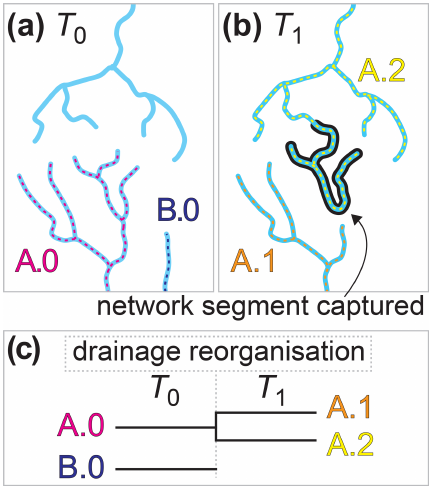
Figure 1. Conceptual model of drainage reorganisation and river- ine species macroevolution. Three stream networks exist in a hypo- thetical landscape at time T 0 (a) . Riverine species A.0 inhabits the lower-left stream network and B.0 inhabits the lower-right network. Drainages reorganised between T 0 and a later time, T 1 . Reorganisa- tion was carried out by a stream capture whereby a network segment broke off the lower-left network and joined the upper network (b) . Members of species A.0 that existed in the captured segment dis- persed throughout the upper network, creating two populations of this species in distinct stream networks that speciated child species A.1 and A.2. Drainage reorganisation also led to the stream network of B.0 disappearing, driving the extinction of this species. The lin- eage history of the species before and after drainage reorganisation is presented in a phylogenetic tree (c) . After Albert et al.